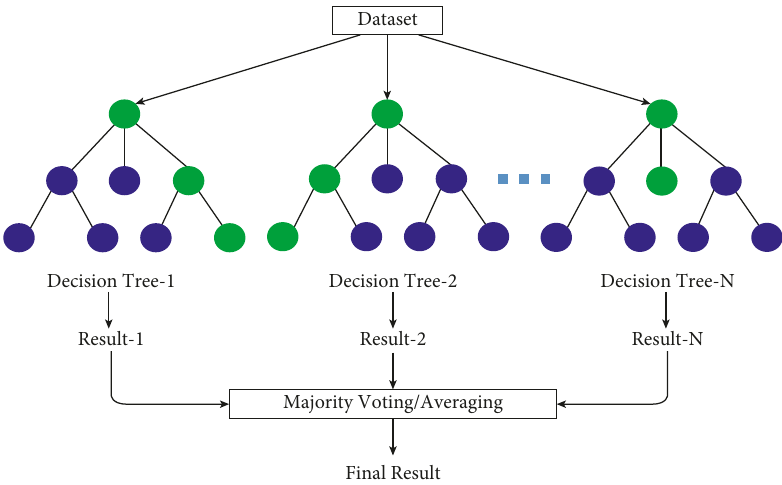
Figure 2: Random forest model (adapted from Analytics Vidhya, 2020).